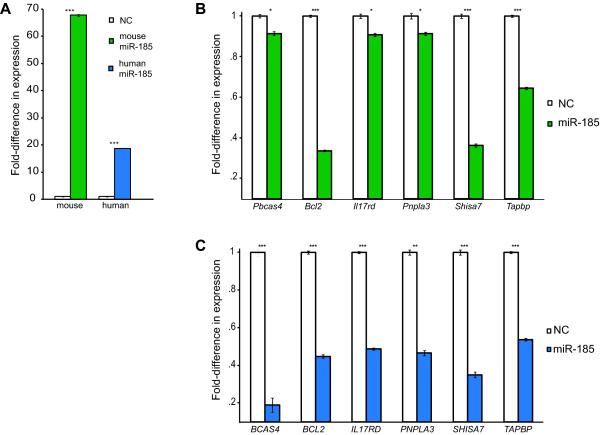
miR-185 mediates conserved crosstalk between Pbcas4 and BCAS4 and protein-coding gene ceRNAs in mouse and human. (a-c) An increased concentration of miR-185 in mouse and human neuroblastoma cells (N2A and SH-SY5Y cells, respectively) (a) leads to significant down-regulation of Pbcas4, BCAS4 and five mouse (b) and human (c) orthologous pairs that were predicted to compete for binding of miR-185. Asterisks indicate significance the level of the comparison (t-test) between the expression of target transcripts after transfection of negative control (set to 1) and miR-185 mimic (**P < 0.01; ***P < 0.001, NC; P > 0.01).